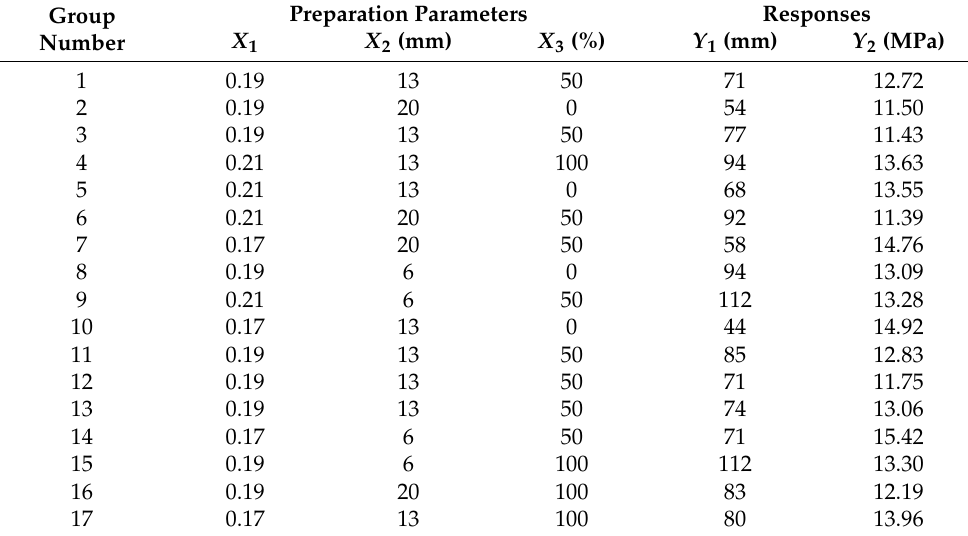
Table 3. Experimental